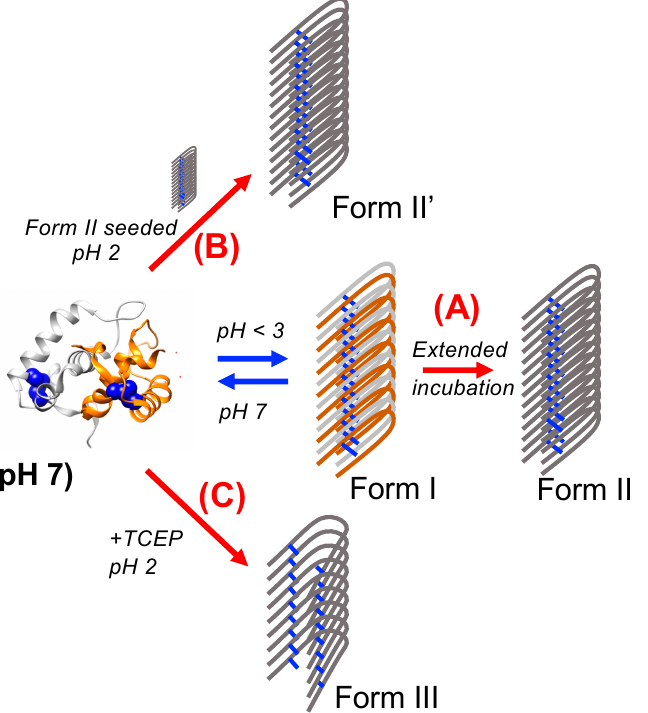
Figure 7. Schematic illustration of the results described in the present study. HdeB (dimeric, disulfide intact) may be induced to form regular fibrils (Form I) at pH conditions lower than 3 (Blue arrow). This original Form I fibril is capable of resolubilizing upon pH shift to 7. Certain alternate protocols (Red arrows) result, respectively, in the formation of irreversibly formed HdeB fibrils that remain stable at pH 7. ( A ) Extended incubation at low pH results in formation of Form II fibrils (disulfide intact, irreversible). ( B ) Form II fibrils may be used as seed to induce the direct formation of irreversible Form II’ fibrils. ( C ) Incubation with reducing agent TCEP during fibril formation at pH 2 induces the formation of irreversible Form III (disulfide deduced, irreversible) fibrils. Forms II and III are distinguishable through FT-IR analysis (Figure 6); at present, we lack evidence to discriminate between the Form II and Form II’ fibril forms. The dimeric backbone image of HdeB at pH 7 was produced from coordinates derived from PDBID 2xuv [5] using UCSF Chimera [19].